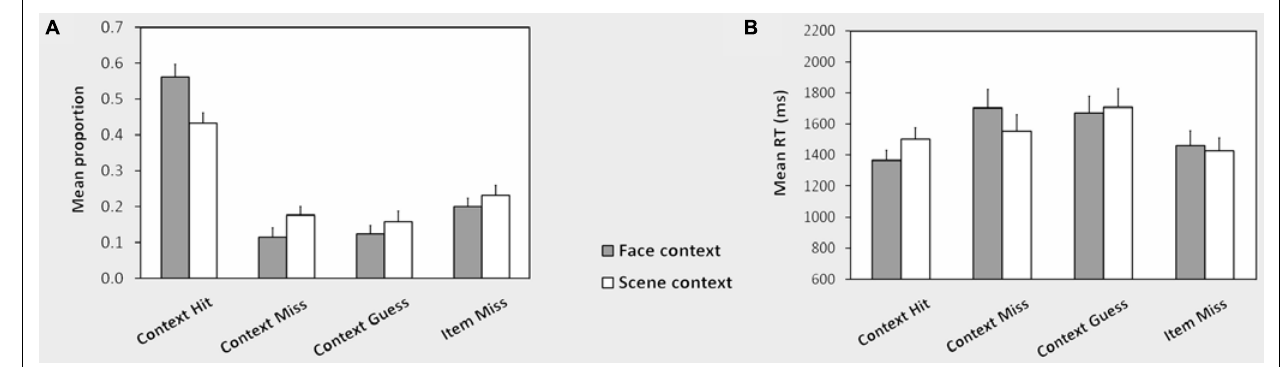
that because there were relatively few face and scene false alarms to new items, RTs were computed collapsed across these conditions. See Behavioral Analysis for definitions of conditions andTest Phase for test phase performance for unstudied items. Error bars represent the standard error of the